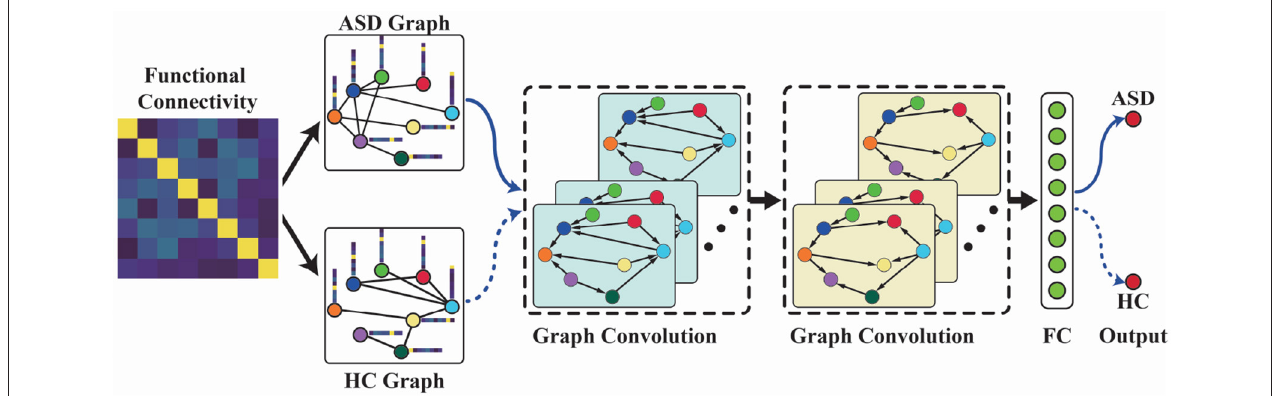
FIGURE 2 | The functional graph discriminative network (FGDN) model for autism spectrum disorder (ASD) classification. The model consists of five layers, i.e., the functional graph construction layer, two graph convolutional layers, fully connected layer, and the output layer.